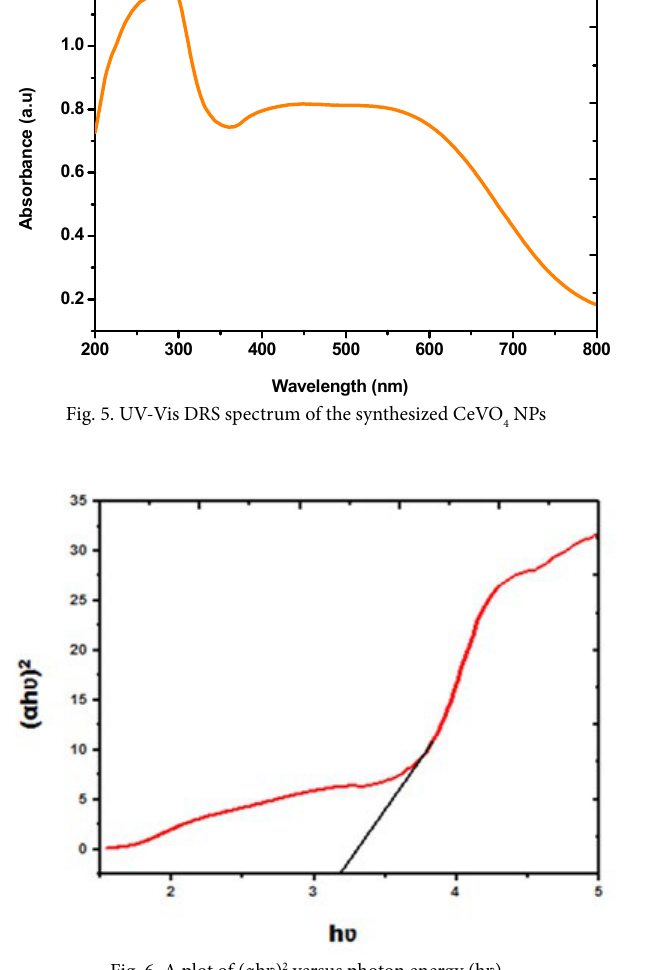
Fig. 6. A plot of (αh ʋ ) 2 versus photon energy (h ʋ Fig. 6 A plot of (αhʋ) 2 versus photon energy (hʋ)